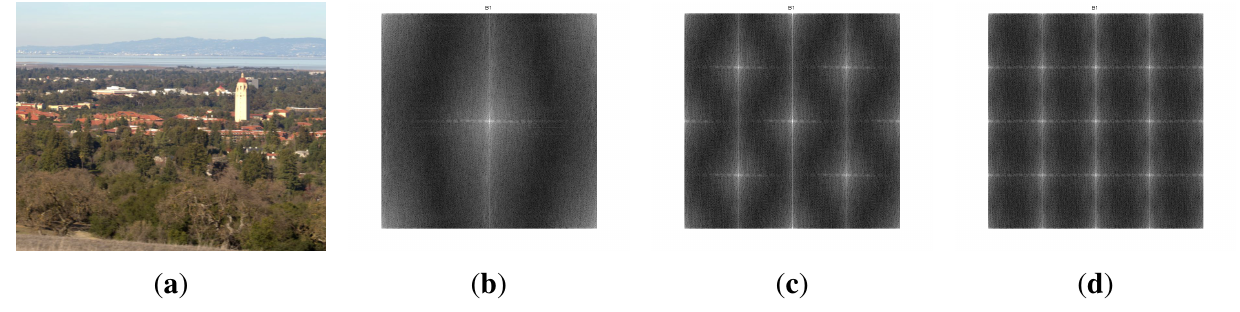
Figure 13. ( a ) The multispectral image by Skauli et al. [102] is used; ( b , c , d ) Log-magnitude representation of spatial arrangements for both FS1 and FS2. ( a ) Stanford image; ( b ) P5